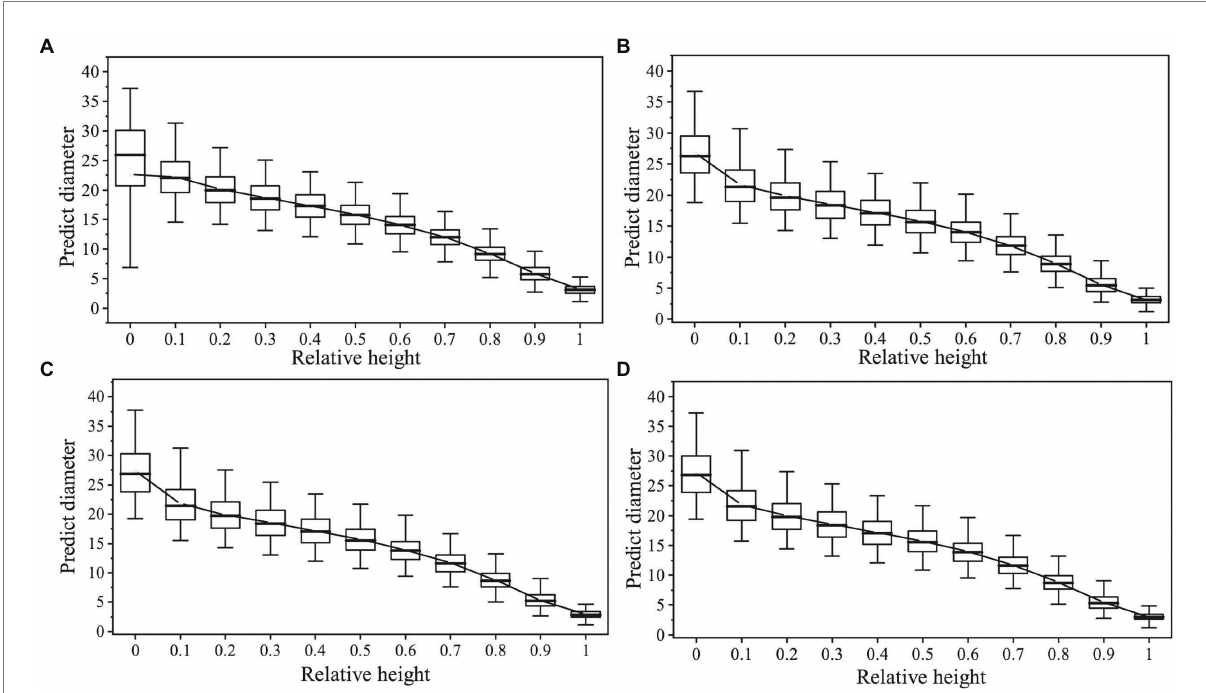
FIGURE 4 Box plot of the predicted diameter against the relative tree height by using the Kozak (2004) model. (A) Nonlinear regression model without density factor; (B) nonlinear regression model with density factor; (C) nonlinear mixed effect model with density factor; (D) quantile regression model with density factor.